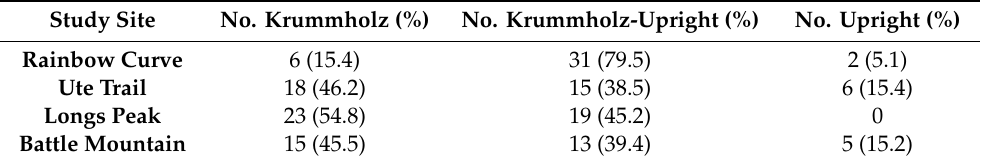
Table 3. Growth form classifications for tree islands at each study site.